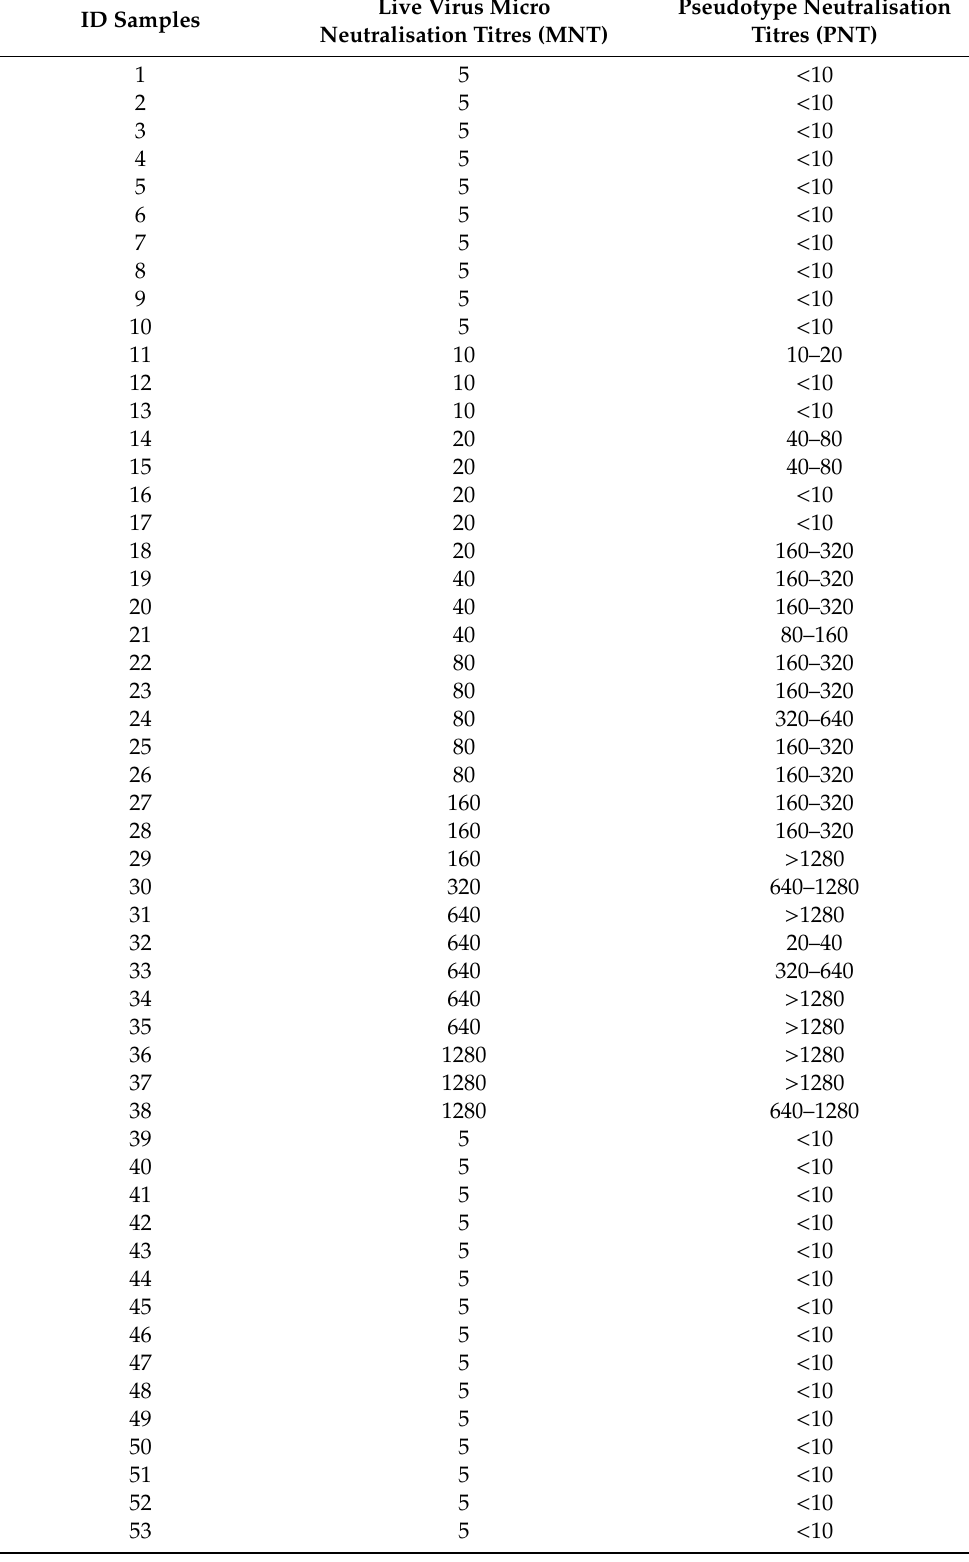
Table 2. Panel of human sera tested by live virus MN and pseudotype-based neutralisation assays. Responses against SARS-CoV-2 are expressed as antibody titres for both assays (end-point